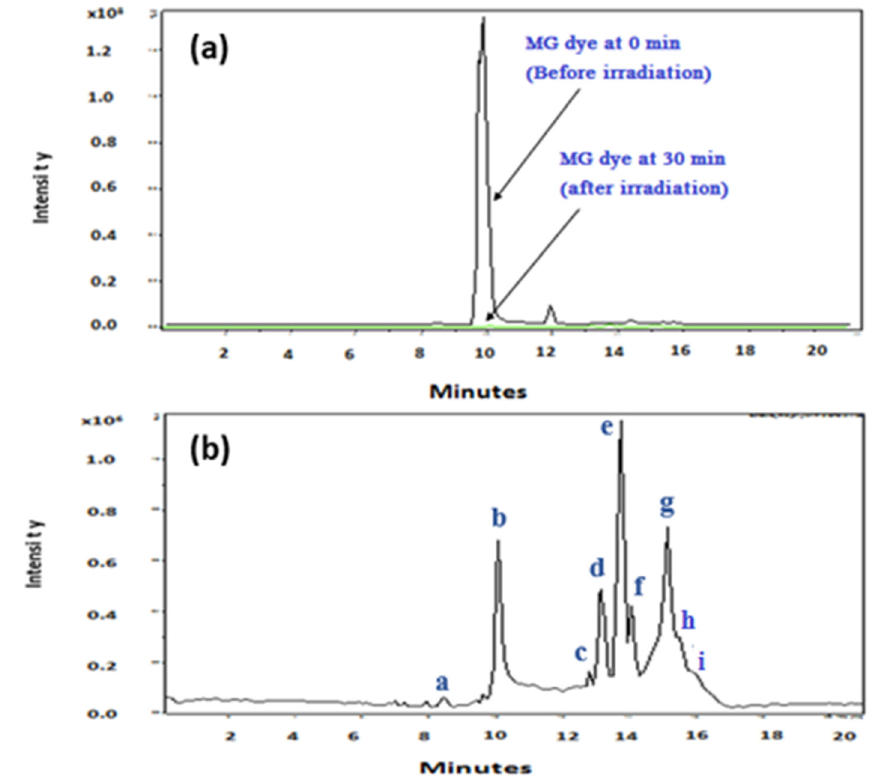
Figure 11. LC-MS chromatogram of ( a ) overlapped chromatogram of MG dye and its degraded products ( b ) the degraded products formed with 30 min of solar irradiation with max of a–i are 618, 620.1, 615.4, 607.9, 598.1, 599.0, 589.6, 580.2, and 577 nm, respectively.